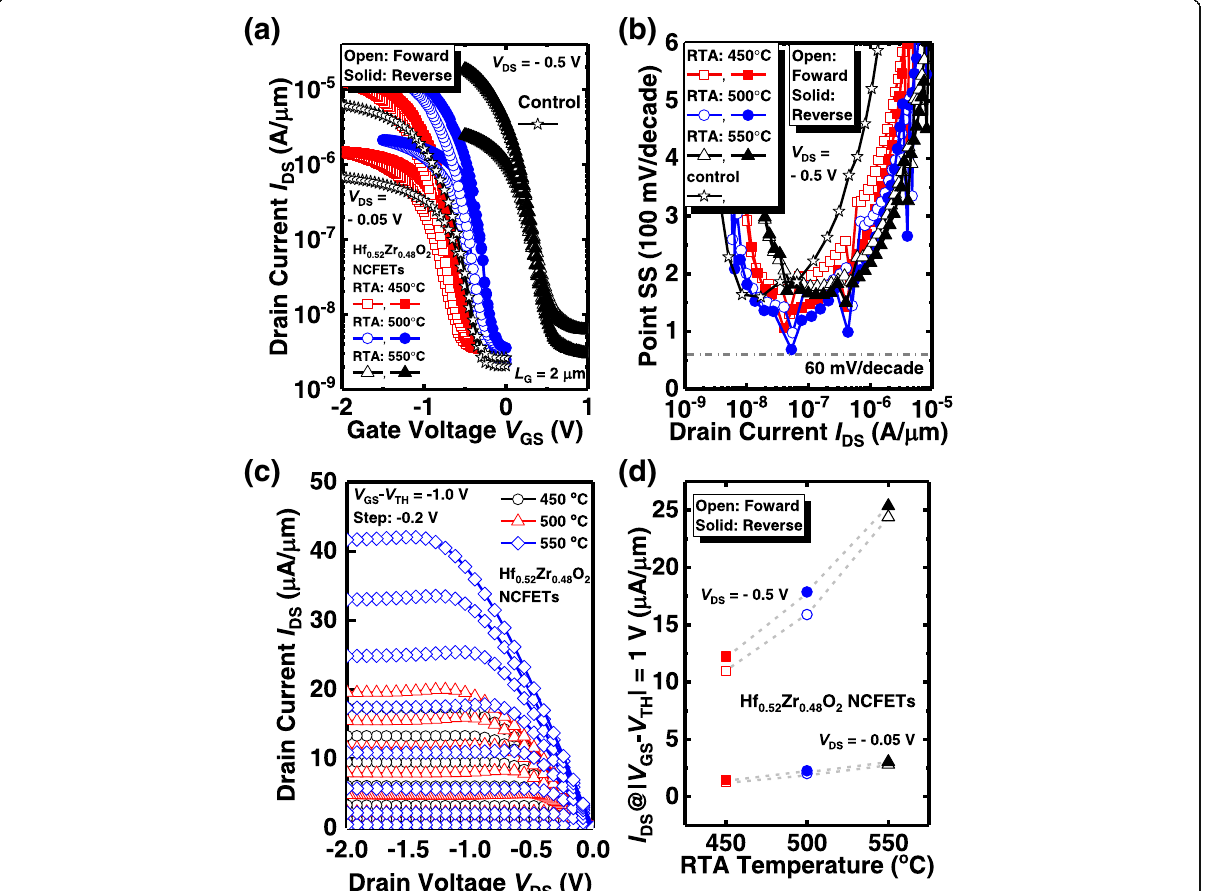
Fig. 4 ( a ) Measured I DS - V GS curves for NCFETs with Hf 0.52 Zr 0.48 O 2 ferroelectric and control device. ( b ) Point SS vs. I DS curves showing that NCFETs have the steeper SS compared to control MOSFET. ( c ) I DS - V DS curves for the NCFETs demonstrating the typical NDR phenomena. ( d ) Comparison of the I DS for the NCFETs annealed at various temperatures at a gate overdrive of 1